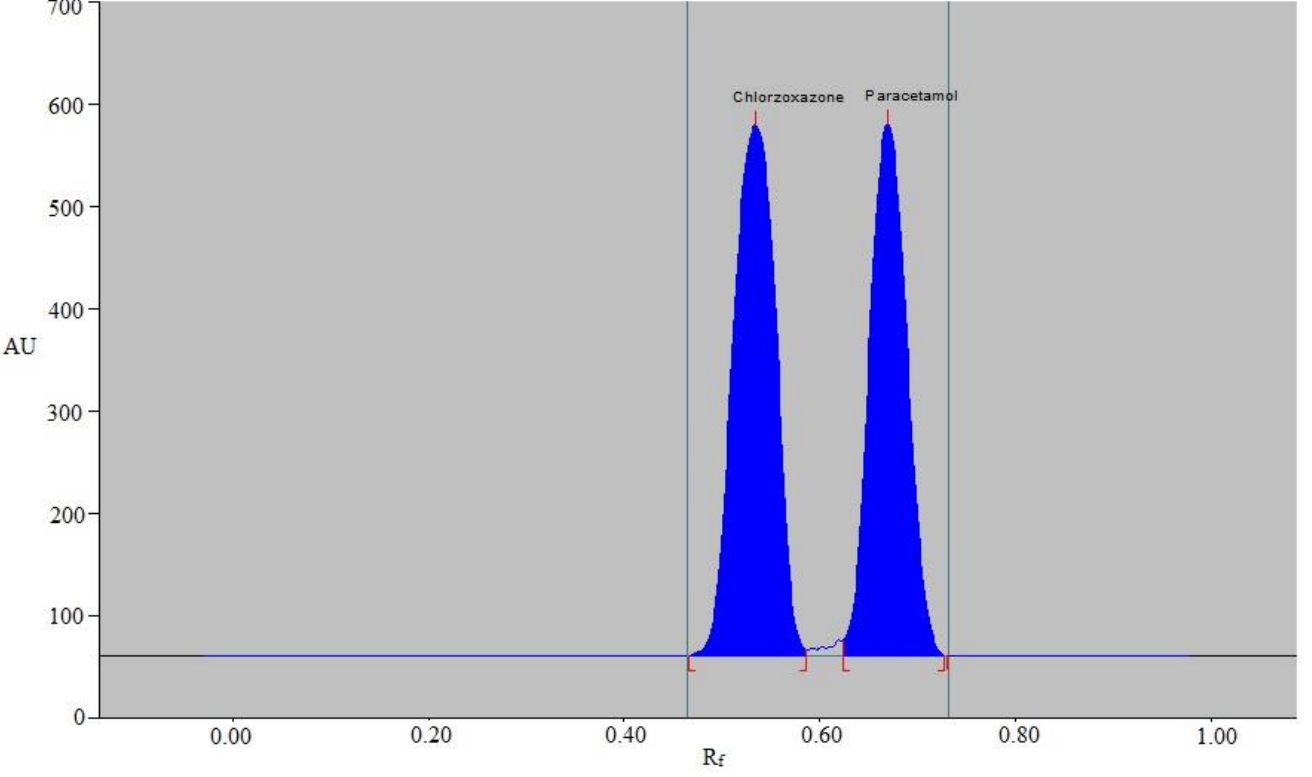
Figure 2. Representative high-performance thin-layer chromatography ultraviolet (HPTLC-UV) chromatograms of standard CZN and PCT.